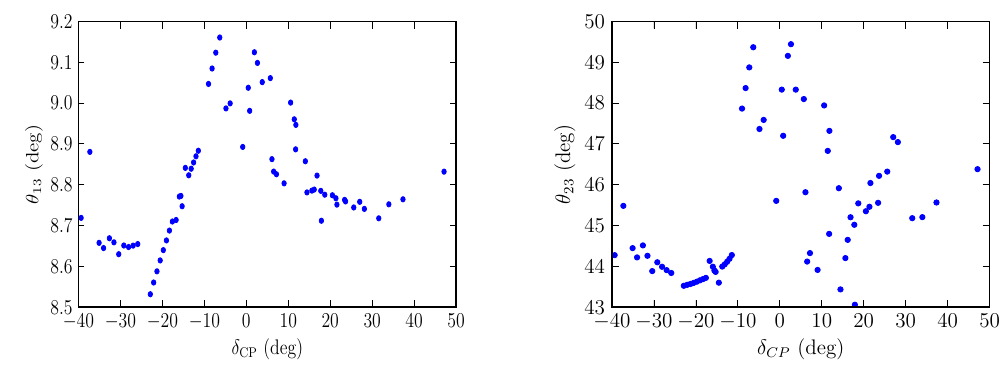
Figure 6 . Comparisons of the Dirac CP phase angle to neutrino mixing angles (cid:18) 13 ; 23 for the model in the type-II seesaw